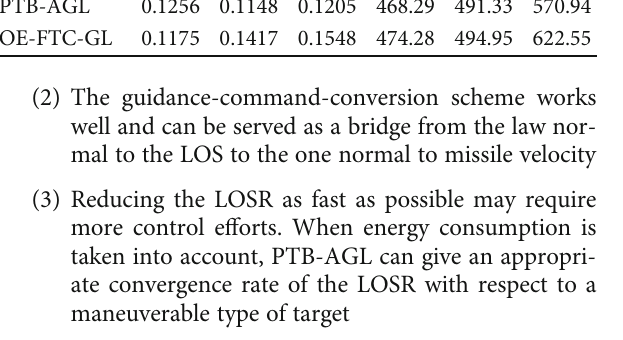
Total energy consumption